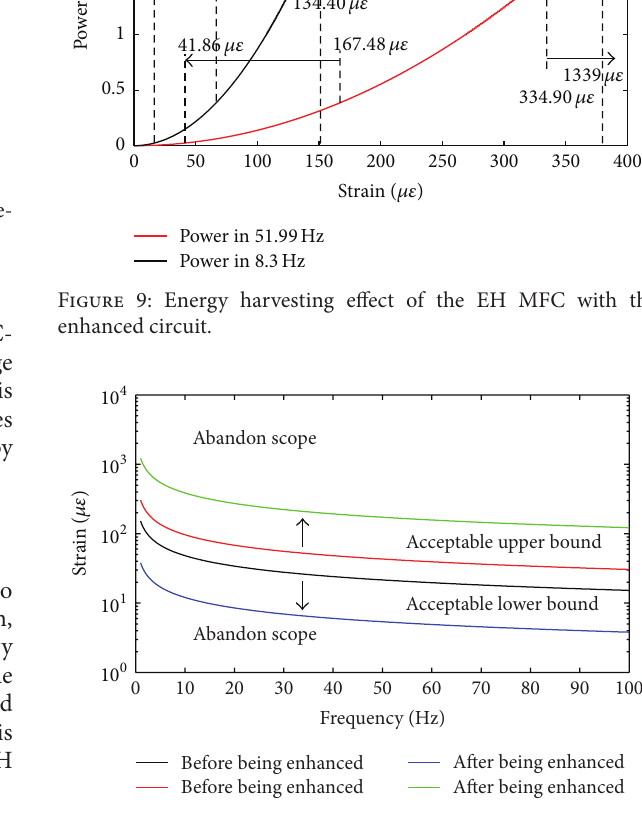
Figure 10: Effect of the enhanced circuit